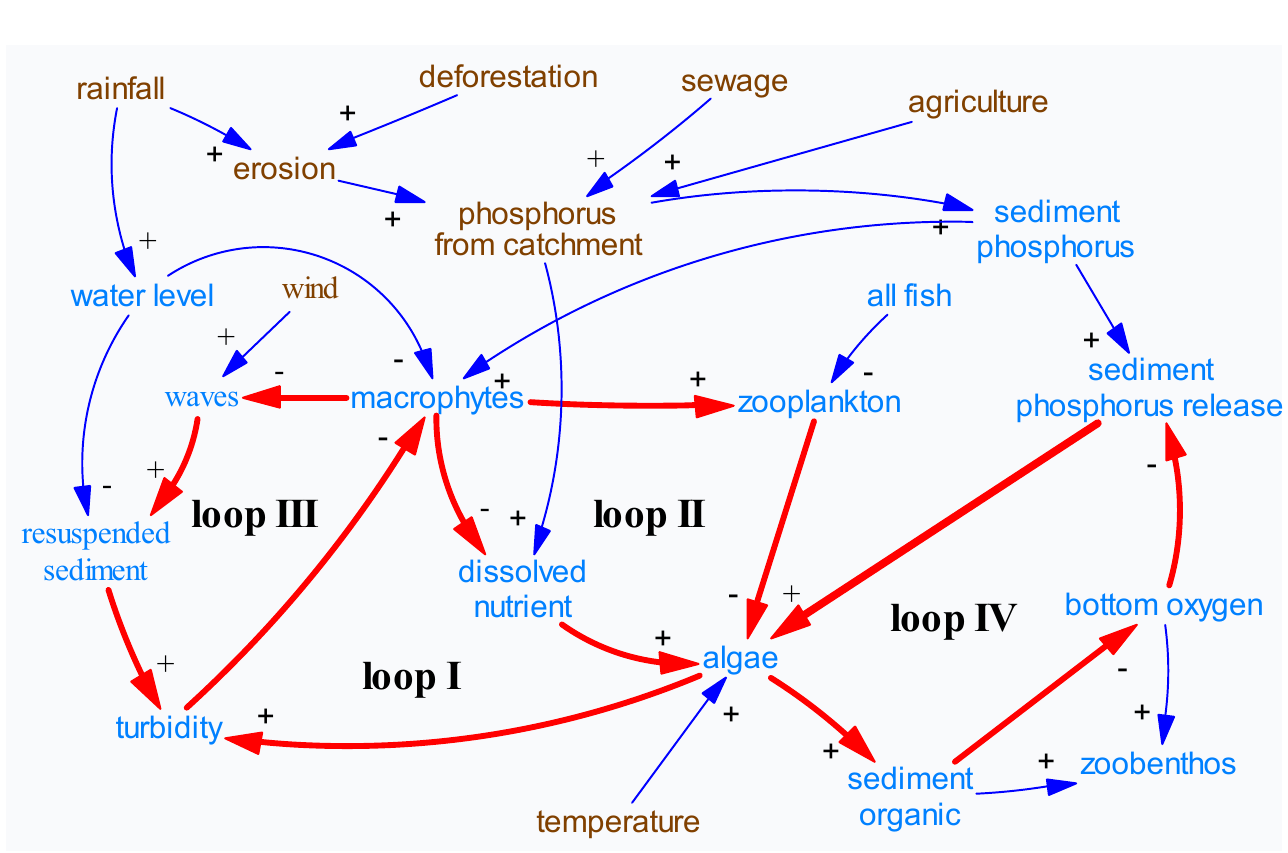
Figure 2. A causal loop diagram for the Erhai catchment system based on the literature and the key components within the lake (blue labels) and its catchment (brown labels). The arrows show the direction of the effects of one component on another, where the ‘+’ and ‘ − ’ signs denote positive and inverse relationships, as envisaged in bivariate scatter plots with positive and negative correlation coefficients, respectively. Specific interactions that define loops I–IV are shown in red.